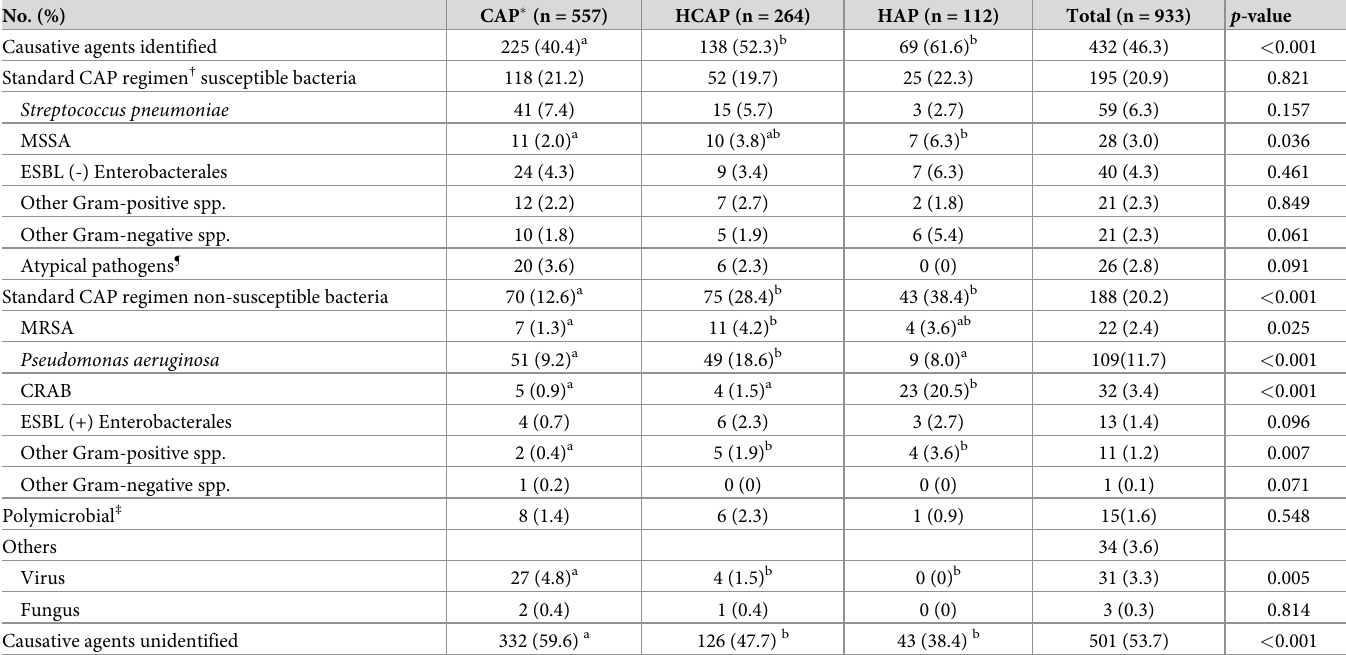
Table 2. Microbiological distribution of hospitalized pneumonia based on the